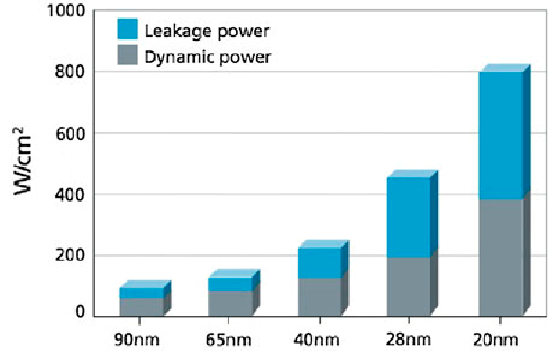
Figure 1. Leakage power vs. dynamic power [1].